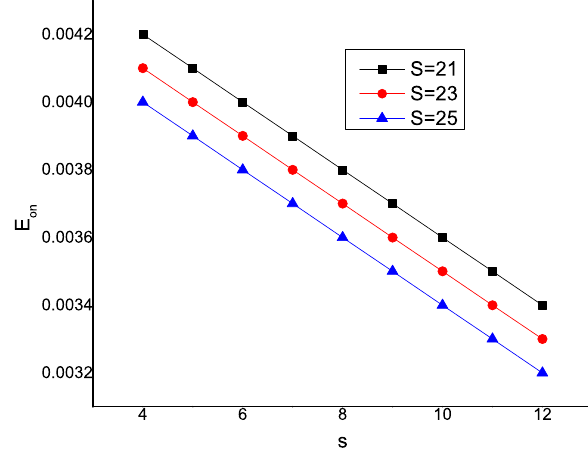
Figure 5. Effect on E on